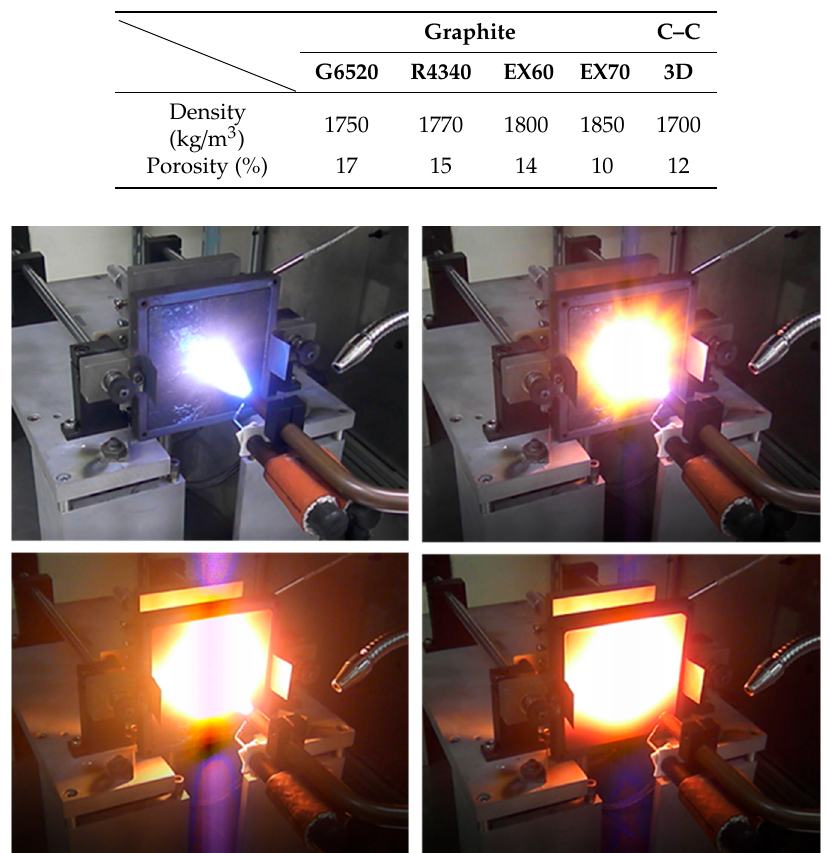
Figure 5. Erosion test results for the 3D C–C composite specimen after 5 s ( upper left ), 40 s ( upper right ), 100 s ( lower left ), and 120 s ( lower right ).